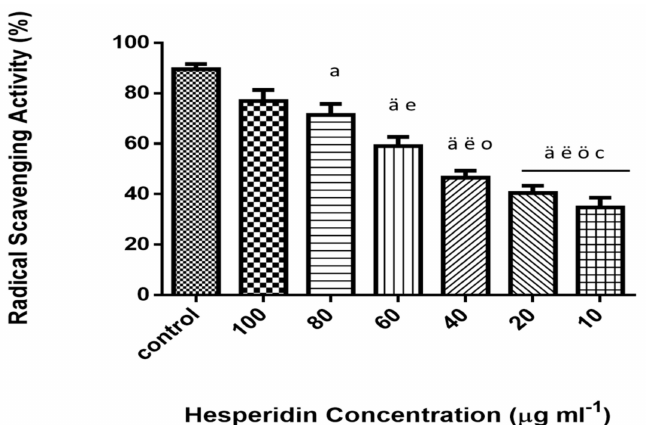
Figure 1. DPPH free radical scavenging activity of hesperidin (%) at di ff erent concentrations (10–100 µ g mL − 1 ). Data represent the means ± standard error (SE), n = 10. Control (vitamin c). a Significant di ff erence from the control group at p < 0.05, ä at p < 0.001. e Significant di ff erence from group treated with 100 µ g mL − 1 at p < 0.05, ë at p < 0.001. o Significant di ff erence from group treated with 80 µ g mL − 1 at p < 0.05, ö at p < 0.01. c Significant di ff erence from group treated with 60 µ g mL − 1 at p < 0.05 (IC50 value 53.46 µ g ml − 1 ).